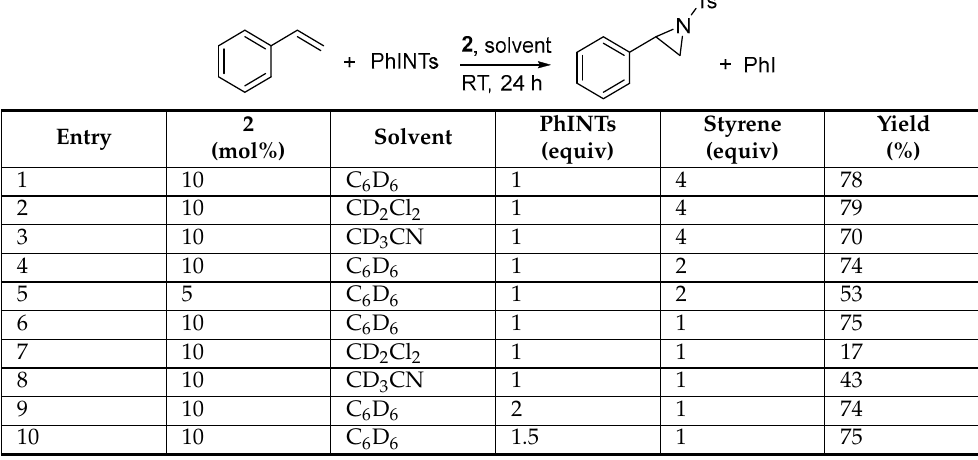
Table 1. Optimization of aziridination conditions.